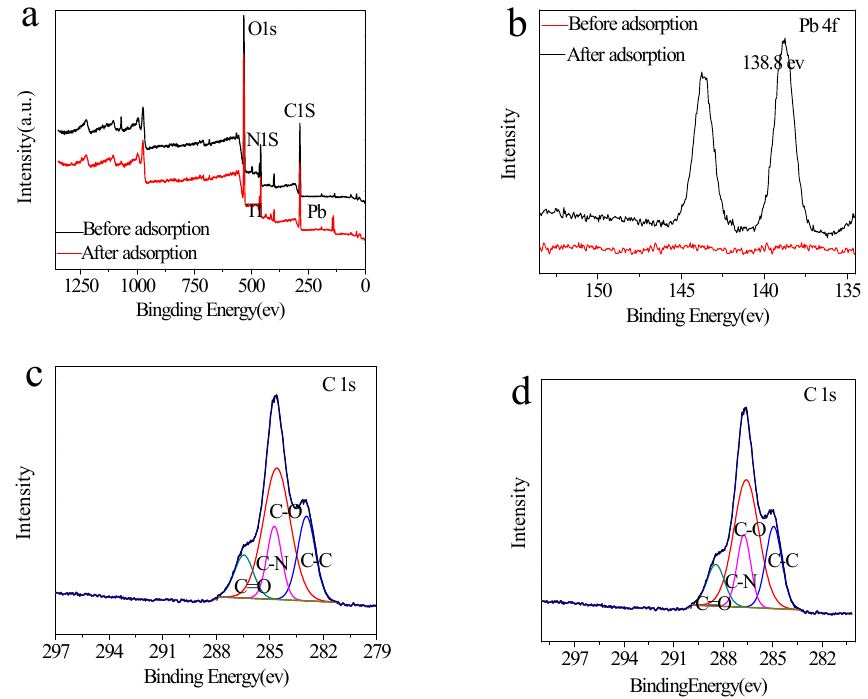
Figure 3. XPS survey spectra of ( a ) MIL-125/CS and MIL-125/CS-Pb, ( b ) Pb 4f, ( c ) C1s of MIL-125/CS and ( d ) C1s of MIL-125/CS-Pb.